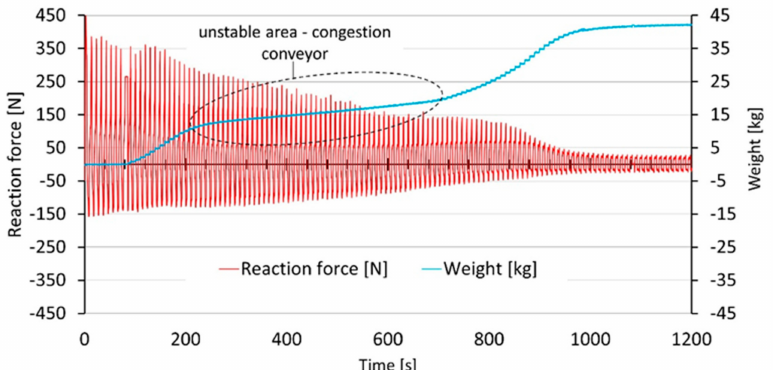
Figure 8. Reaction force acting on the driving mechanism at the 30% level of shifting speed for the transported abrasive material, STEEL GRIT GH50, and depending on gradual feeding of the conveyor with 45 kg of the abrasive